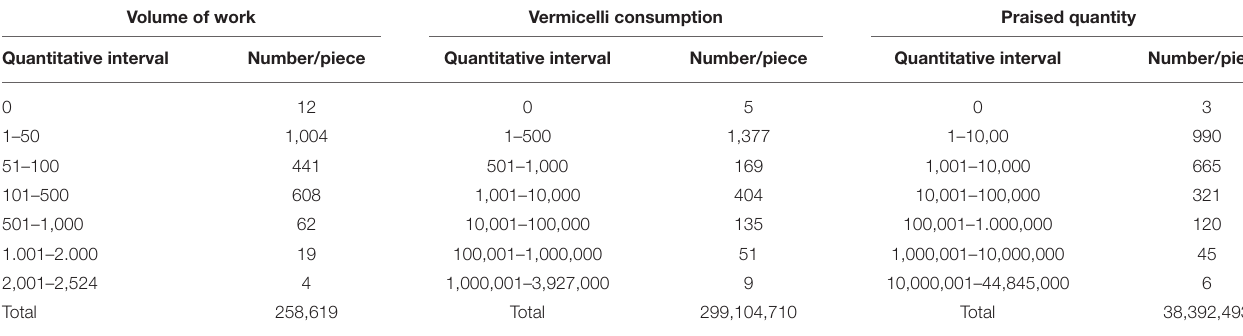
TABLE 2 | Statistics of works, fans and likes of the disseminators of short fitness videos on